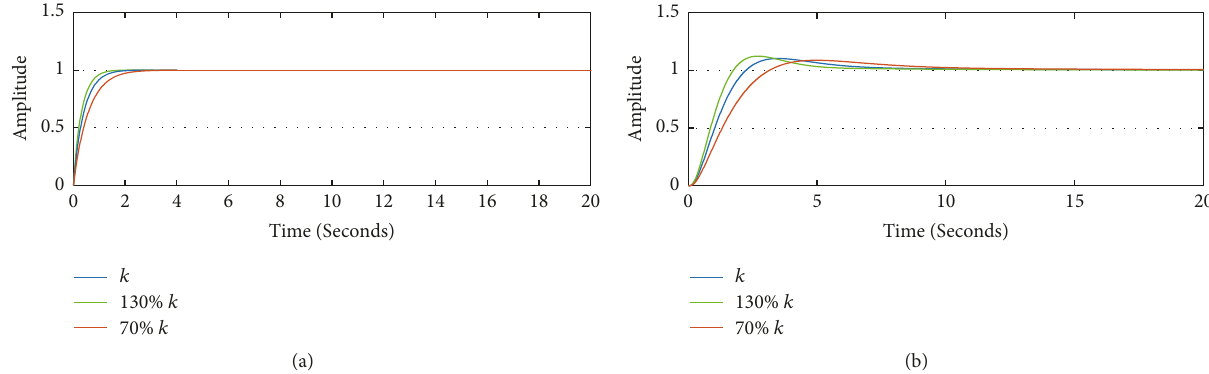
Figure 15: Step responses of 𝑃 1 (𝑠) with different FOPID controllers ((a) FOPID controller proposed in this paper, (b) FOPID controller in [30]).